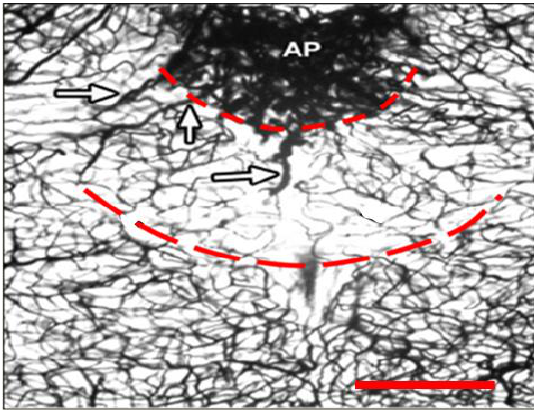
Figure 5. Capillaries of the pNTS in the Rat Brain. Lower capillary density, particularly midline, is visible in the pNTS, the zone between dashed lines, in this cross-sectional view. Arrows indicate short vessels that carry ―re-entrant‖ venous blood to capillaries of the pNTS after prolonged residence in the AP. The scale bar is 400 microns. Photo from [56], by permission of Literatura Medica,